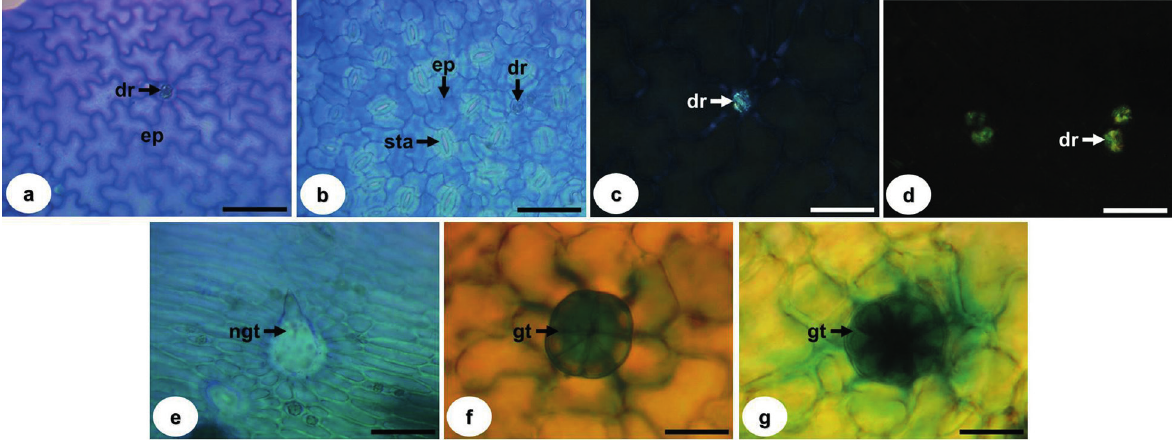
Figure 2 - Paradermal sections of the leaf blade of Artocarpus heterophyllus . a , b , e , f and g : optical microscopy; c and d : polarized light microscopy; a and c : adaxial face; b , d , e , f , and g : abaxial face. Abbreviations: dr = druse; ep = epidermis; gt = glandular trichome; ngt = non-glandular trichome; sta = stomata. Bars: a , b and e = 50 µm; c , d , f and g = 20